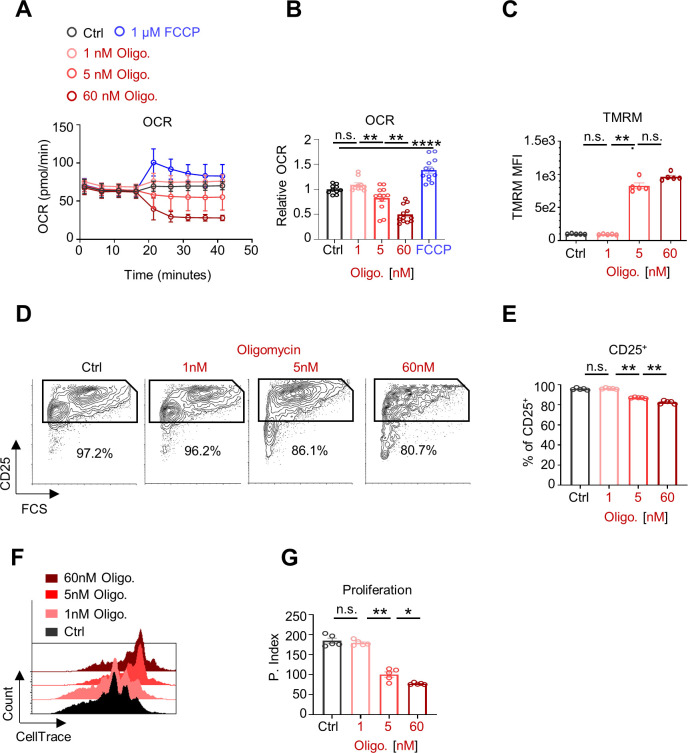
Oligomycin inhibits CD8+ T cell respiration, activation, and proliferation.(A) Oxygen Consumption Rate (OCR) of isolated naïve CD8+ T cells treated with the indicated oligomycin, FCCP concentrations or left untreated. (n = 5 biological replicates). (B) Bar graph summarizing the results in A as a ratio between OCR pre and post treatment (Relative OCR). (P value ** 0.0072, **0.0018, ****>0.0001) (C) Bar graph summarizing TMRM fluorescence intensity, measured by flow cytometry, of naïve CD8+ T cells that were either treated with the indicated oligomycin concentrations or left untreated. (P value ** 0.0072) (D-G) CellTrace-labeled PBMCs from human donors were activated with anti-CD3/28 for 72 hr in the present or absent of indicated concentrations of oligomycin. (D) Representative Flow cytometry plots of FSC vs. CD25 gated on CD8+ T cells from untreated cells or oligomycin treated cells. Numbers indicate the frequencies of CD25+ cells. (n = 5 biological replicates) (E) Bar graph summarizing the results in (D). (P value ** 0.0072, ** 0.0072). (F) Representative Flow cytometry overlay histogram of CellTrace intensity gated on CD8+ T cells from untreated cells (Ctrl) or Oligomycin treated as indicated. (G) Bar graph summarizing the results in F as Proliferation Index. (P value ** 0.0072, * 0.0159) Statistical method, non-parametric Mann-Whitney test, mean ± s.e.m.